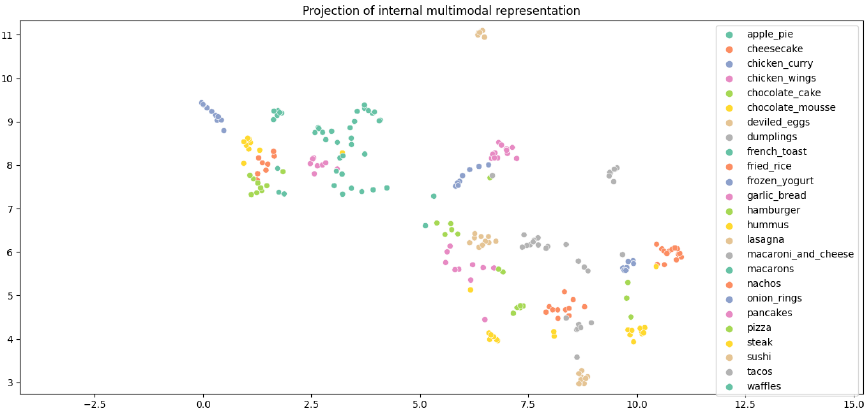
Figure 2. Visualization of the projection of multimodal latent space (I+T) for the tasty